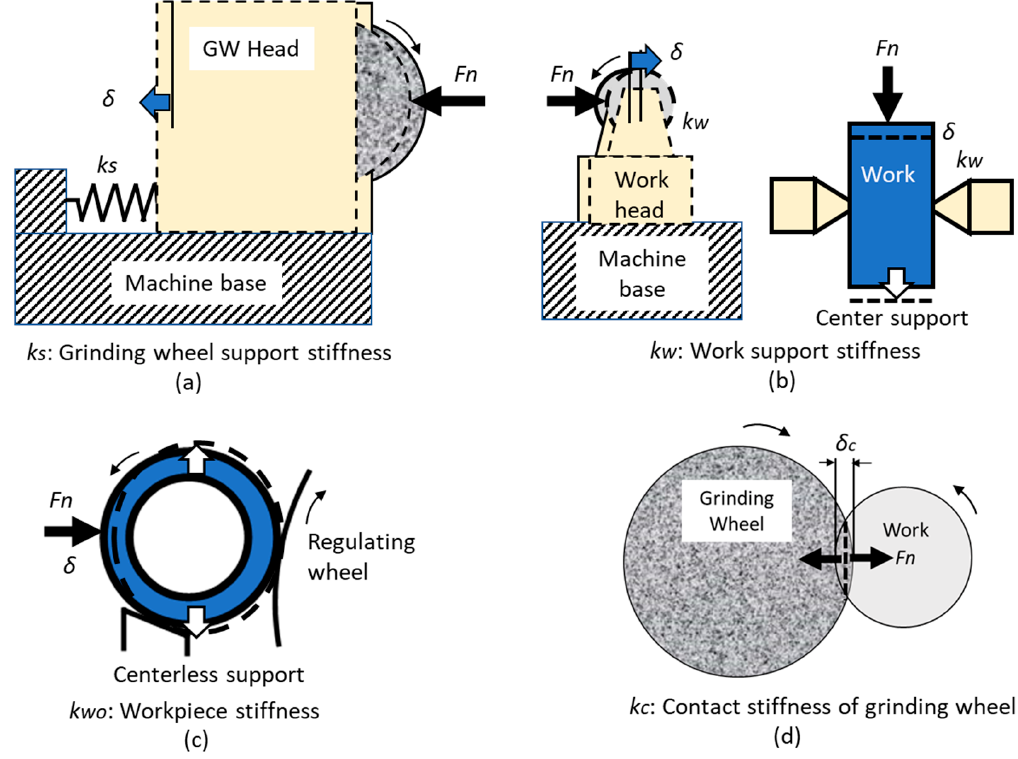
Figure 2. Components of equivalent system stiffness in plunge grinding system. ( a ) Stiffness of grinding wheel head; ( b ) Stiffness of work head; ( c ) Stiffness of workpiece; ( d ) Contact stiffness of grinding wheel.